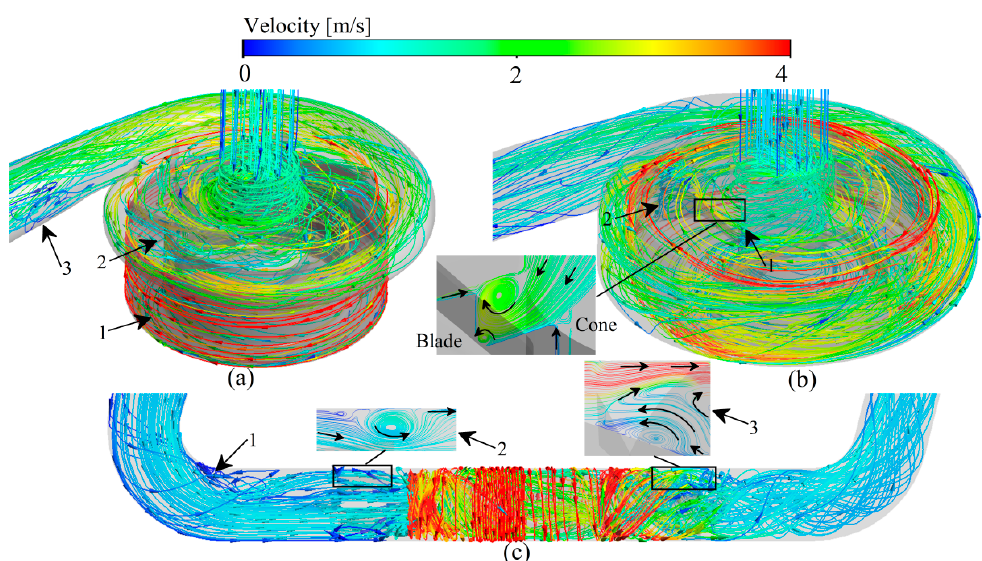
Figure 6. Typical streamlines of the relative velocity predication of three studied VADs: ( a ) CH-VAD; ( b ) HVAD; ( c ) HMII.